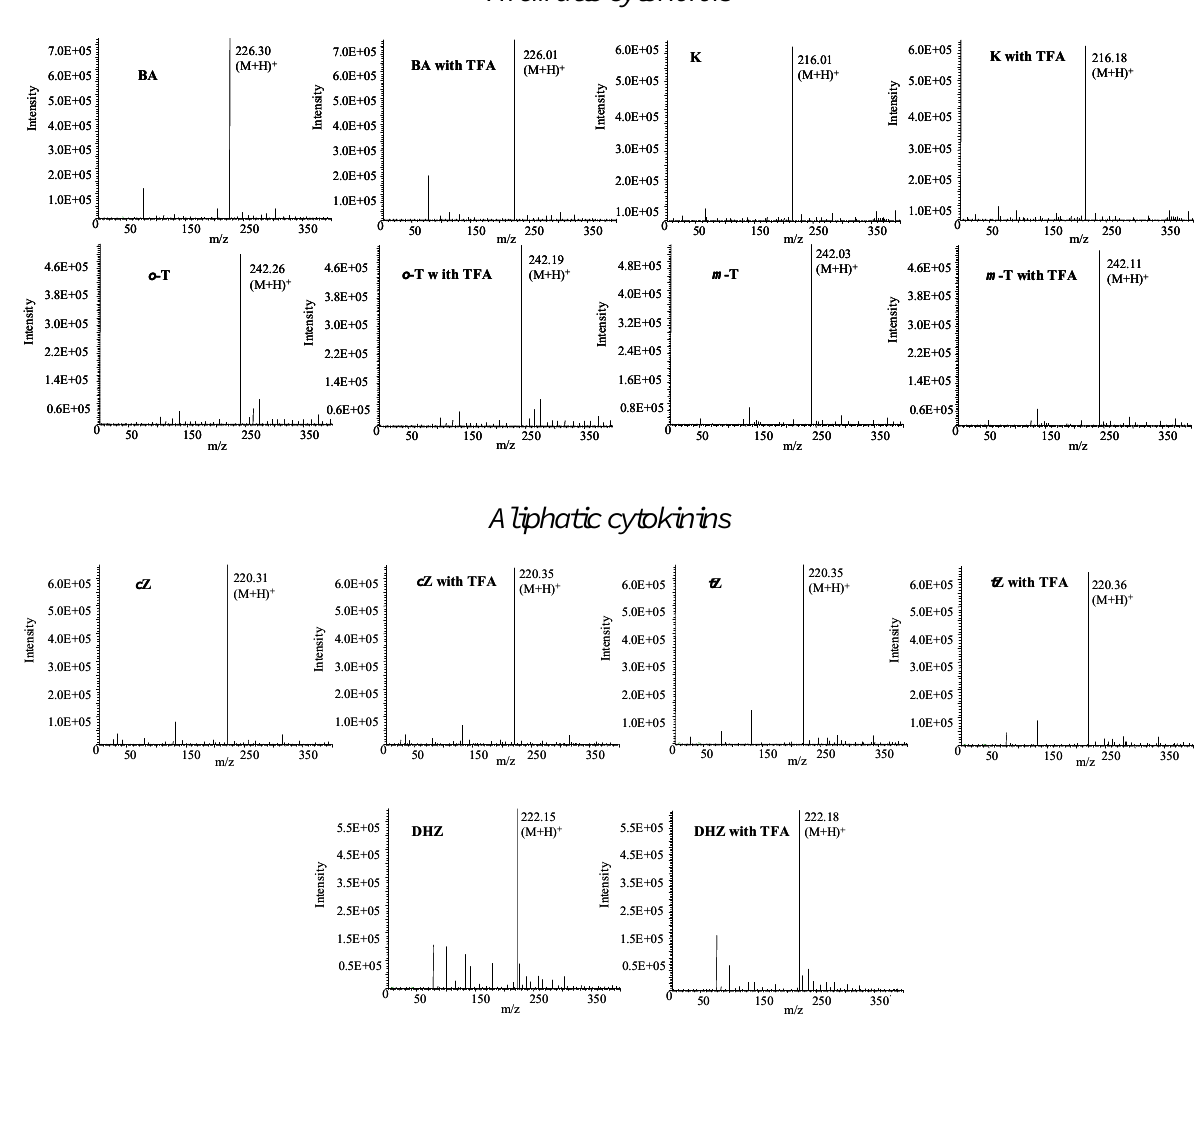
Figure 6. Mass spectra of phytohormones measured with or without addition of TFA in mobile phase. Concentration of TFA – 0.001%, mobile phase – methanol:water (50:50, v / v ), capillary voltage 3.5 kV, drying gas temperature 250 °C, nebulizer pressure 5 MPa; drying gas flow 6 L·min -1 ; cone voltage – 20